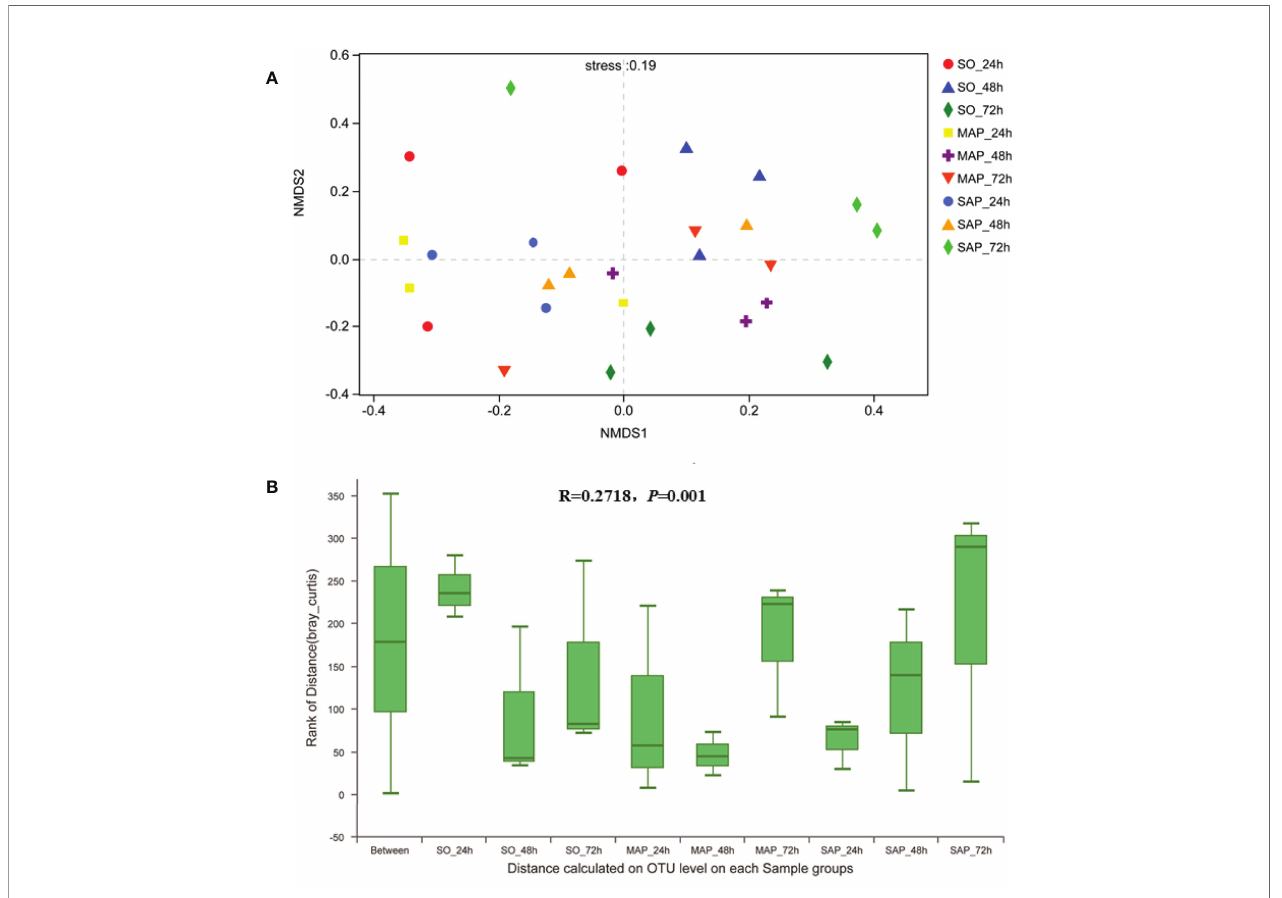
FIGURE 3 | NMDS and ANOSIM analyses of bacterial community composition. (A) The different colors in the NMDS analysis represent different groups. (B) ANOSIM analysis of bacterial community composition of each sample group. SO, Sham operation; MAP, Mild acute pancreatitis; SAP, Severe acute pancreatitis; NMDS, non- metric multidimensional scaling; ANOSIM, analysis of